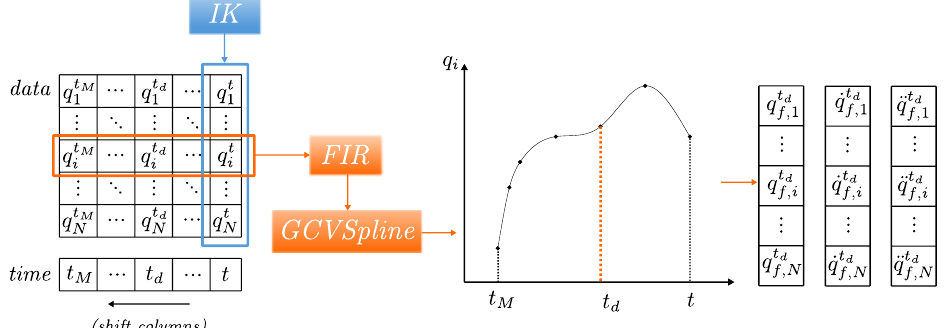
Figure 2. An overview of the filtering and differentiation module. The generalized coordinates from IK are placed into a circular buffer of memory M . The M samples of each signal are filtered using a low pass FIR filter. A generalized cross-validation spline of order N s is then constructed to evaluate the coordinate and derivatives’ value at time instance t d